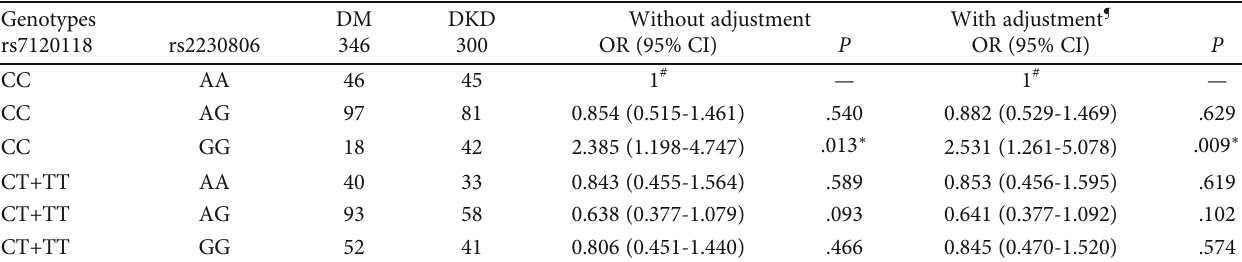
Table 4: The combined e ff ect of LXR- α rs7120118 and ABCA1 rs2230806 polymorphisms on DKD.